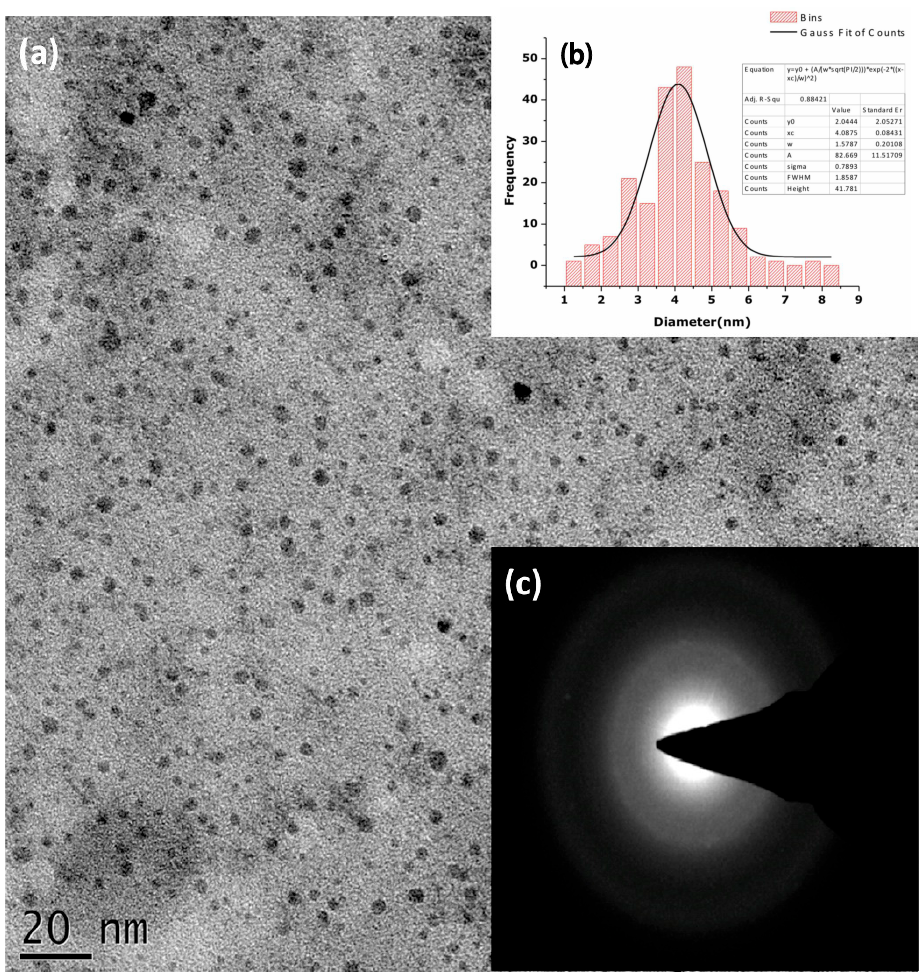
Figure 7. ( a ) HRTEM of the synthesised ZnO NPs ( b ) with their size distribution ( c ) and their SAED pattern. Adapted from [28].